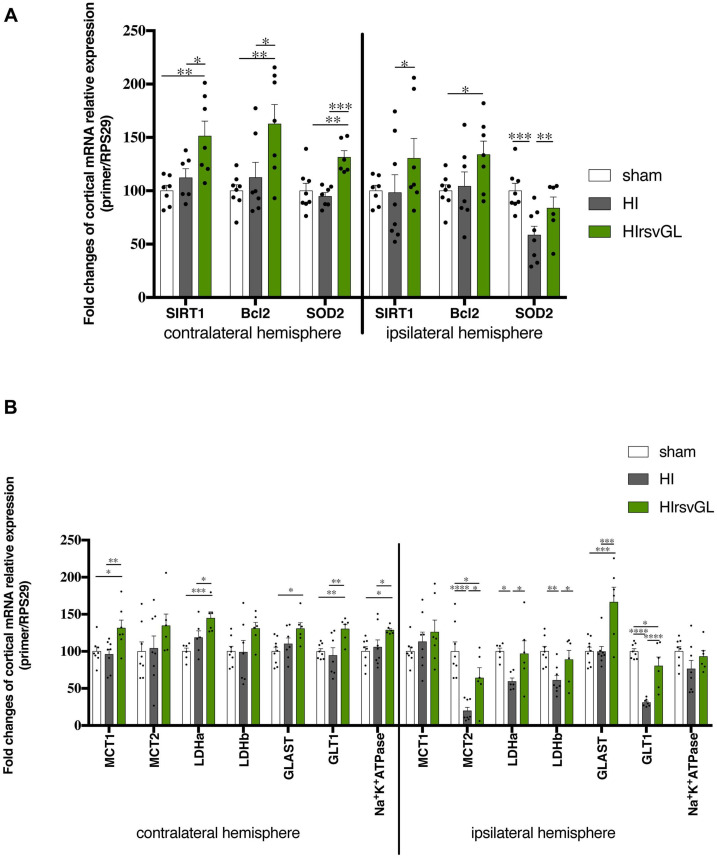
Impact of maternal resveratrol supplementation on cortical mRNA expression of some genes linked to signaling or metabolism. RT-qPCR performed at P9 on cortical samples from contralateral and ipsilateral hemispheres of sham, HIrsvGL, and HI groups (n = 6 for each group, hippocampus and striatum data, see Supplementary Figures 3, 4). (A) Signaling pathway: SIRT1, Bcl2, and SOD2 mRNA levels were quantified using appropriate primer sequences (see Table 1). (B) Metabolic pathway: MCT1, MCT2, LDHa, LDHb, GLAST, GLT1, and Na+/K+-ATPase α2 subunit mRNA levels were quantified using appropriate primer sequences (see Table 1). Results are mean values ± SEM and one-way analysis of variance (ANOVA) with Fisher’s LSD post hoc test. ∗: Significant difference between two groups (∗: p < 0.05, ∗∗: p < 0.01, ∗∗∗: p < 0.001, and ****: p < 0.0001).